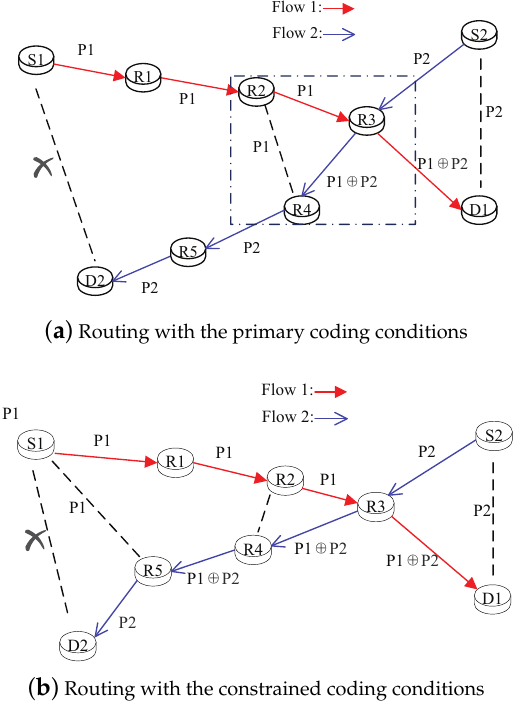
Figure 2. The routing decision with different coding conditions in a two-flow